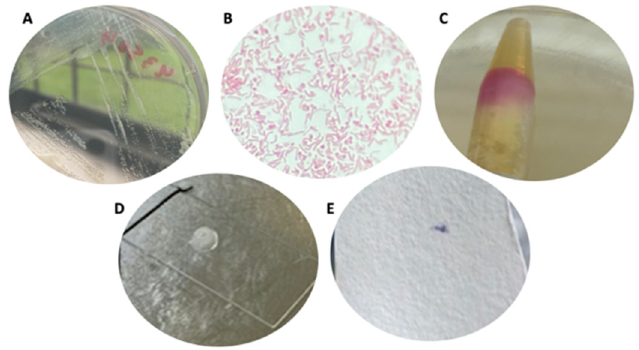
Figure 1. Typical culture and microbiological identification of H. pylori . ( A ) Culture of H. pylori in CA-5%FBS; ( B ) Gram-stained smear; ( C ) Urease test; ( D ) Catalase test; and ( E ) Oxidase test. CA-5%FBS: Columbia agar supplemented with 5% FBS.